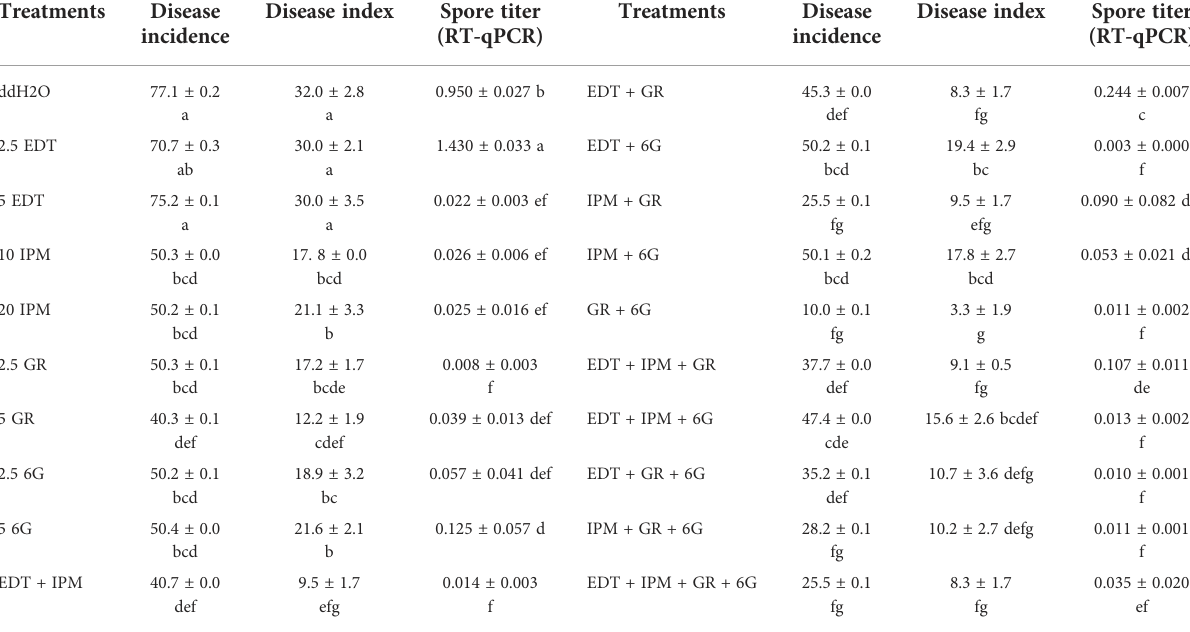
TABLE 3 Effects of metabolite treatments on the occurrence of clubroot on sensitive radish cultivar “ JNYB ” .